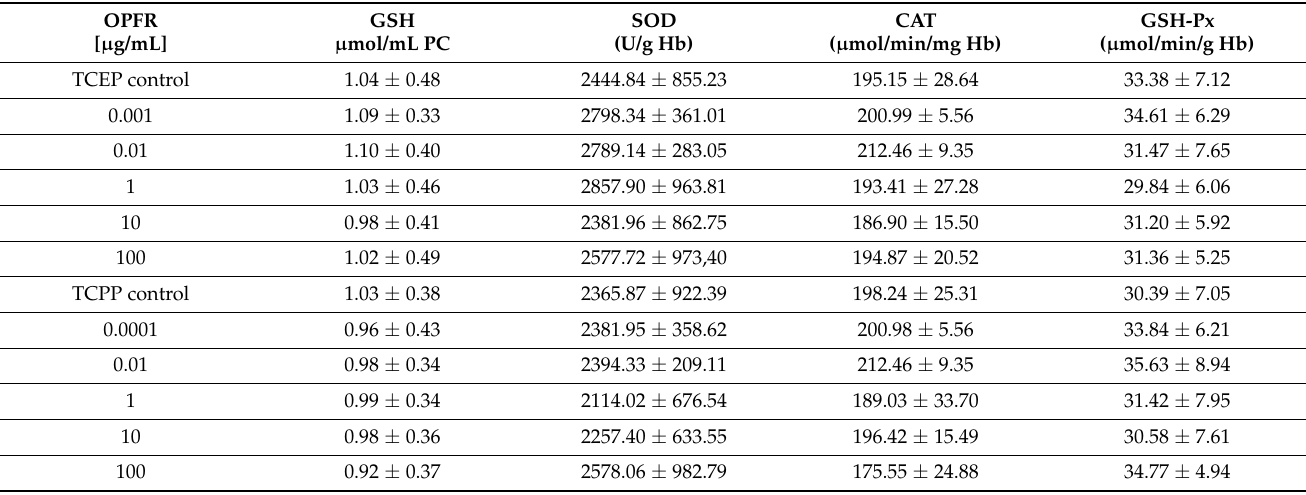
Table 1. The level of GSH and the activities of SOD, CAT, and GSH-Px in control erythrocytes and erythrocytes incubated with TCEP or TCPP at concentrations ranging from 0.001 to 1000 µ g/mL for 24 h. OPFR GSH µ mol/mL [ µ g/mL]